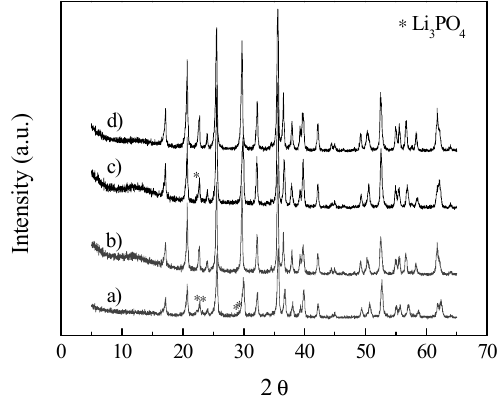
Figure 2. XRD patterns of the materials before ( a and b ) and after ( c and d )